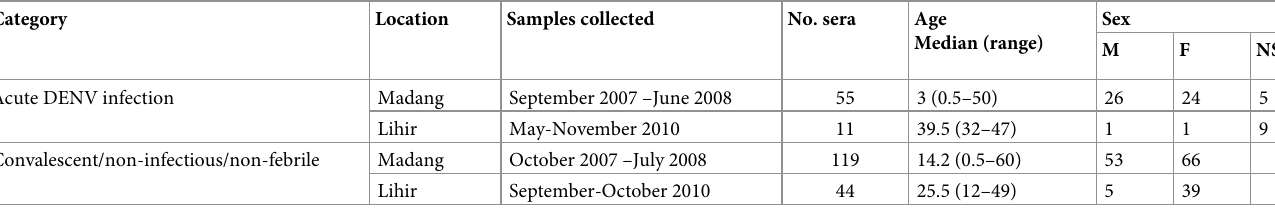
Table 1. Patient clinical and demographic